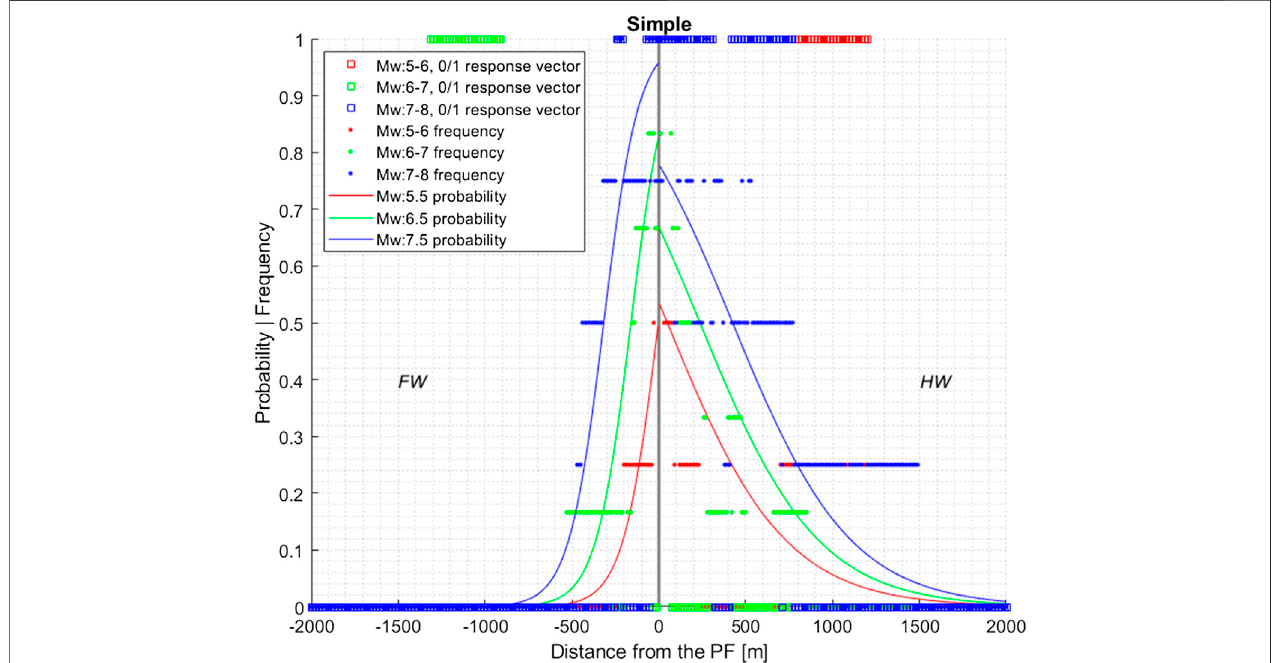
FIGURE 7 | Logistic regression of the distributed rupturing in the database indicating the probability of observing at least a partial distributed rupture (DR) as a function of distance from a principal fault (PF) on hanging wall (HW) and footwall (FW) sides. The squares show the response to the logistic regression of rupturing either occurring (1) or not occurring (0) at a given distance. The points show the DR frequency in respect to the total number of events int each M w class, and the lines indicate the probability of at least a partial DR at a given distance.